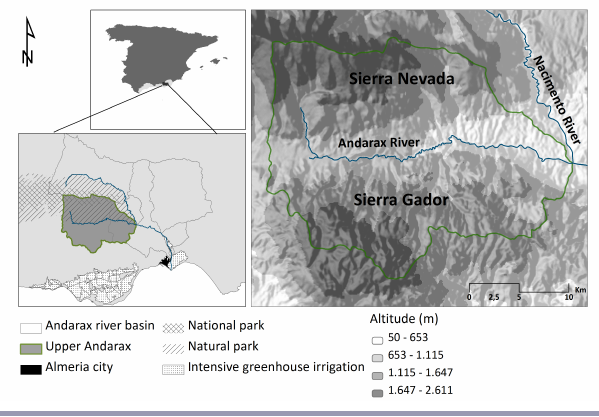
Fig. 1 . Upper Andarax and its location within the Andarax River